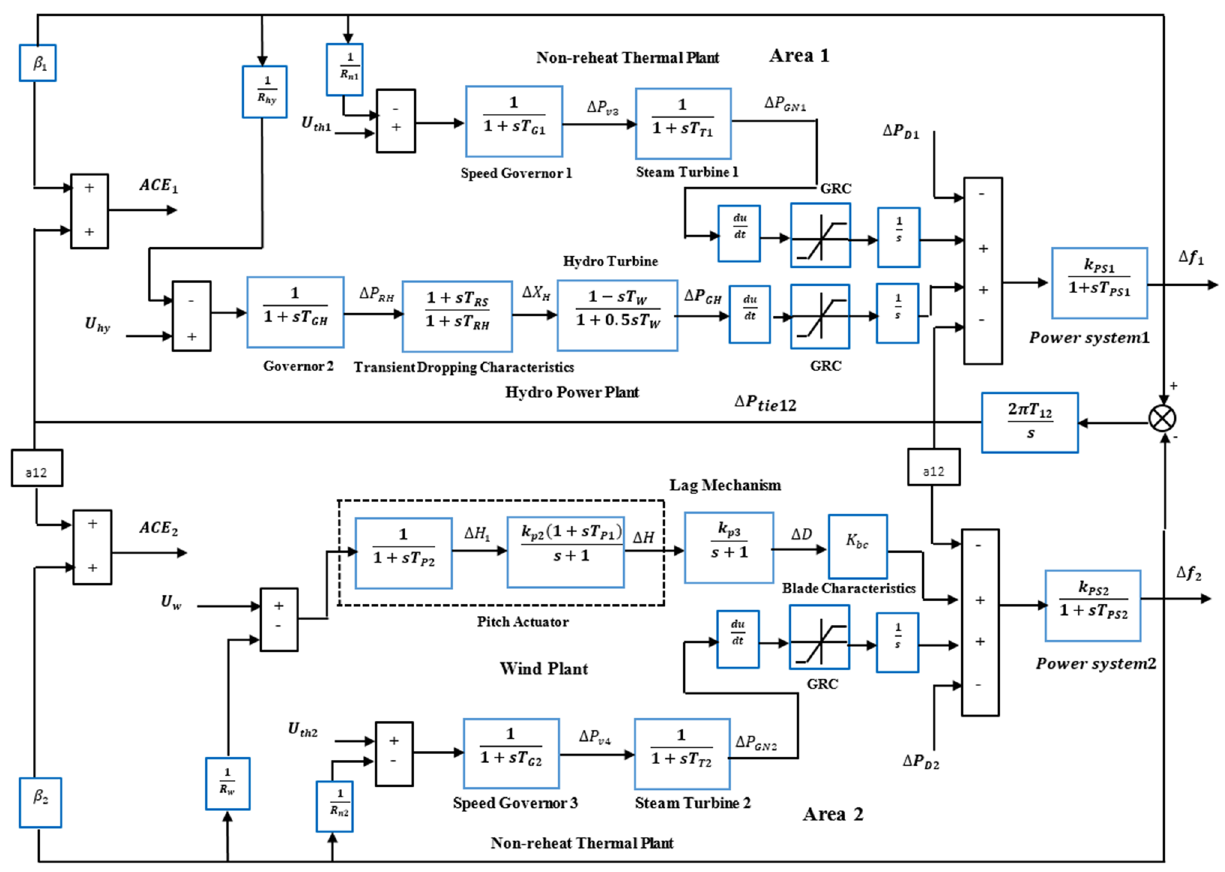
Figure 13. Transfer function model of multi-source power